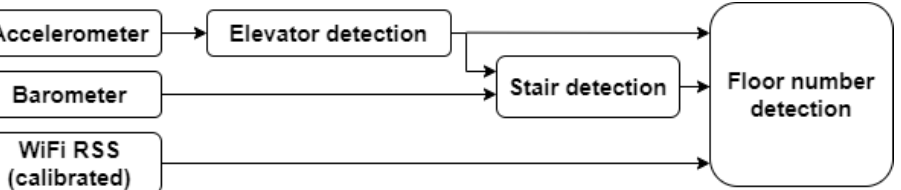
Figure 2. High-level flowgraph of the floor number detection algorithm. This algorithm consists of three phases. First, stairs and elevator usage are detected, and the height change is estimated. Then, RSS measurements are matched with the model-based radio maps, and finally, the output of the first 2 phases is combined to estimate the floor